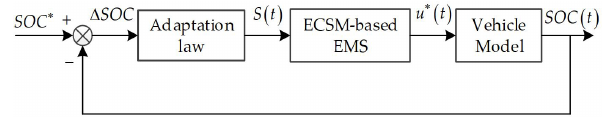
Figure 7. Flow chart of the SOC feedback control